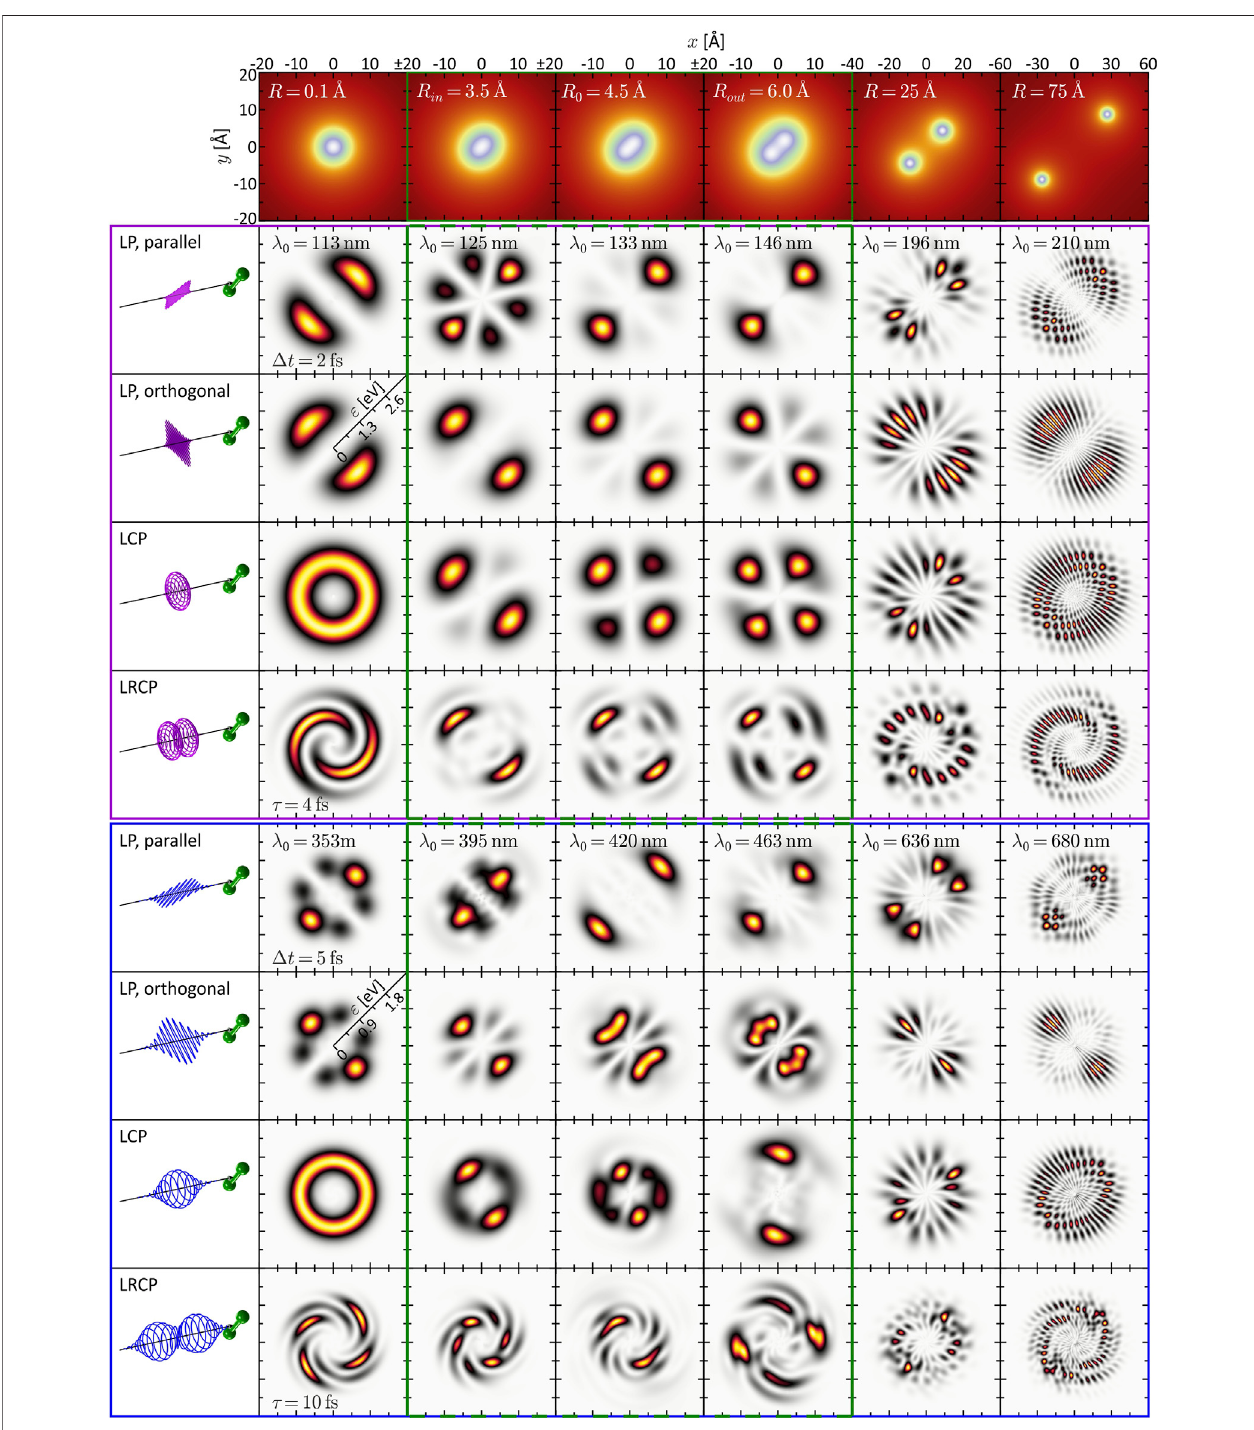
FIGURE 2 | (Color online.) Gallery of calculated and energy-calibrated PMDs created by photoionization of the rigid molecule at different internuclear separations (columns) with different types of laser pulses (rows). The corresponding molecular potentials are shown in the top row. The laser pulses are illustrated on the left-hand side. The upper part (magenta frame) shows the PMDs resulting from one-photon ionization, thePMDs in thelower part (blue frame) result from three-photon ionization. The green frames (second to fourth column) indicate the vibration window.